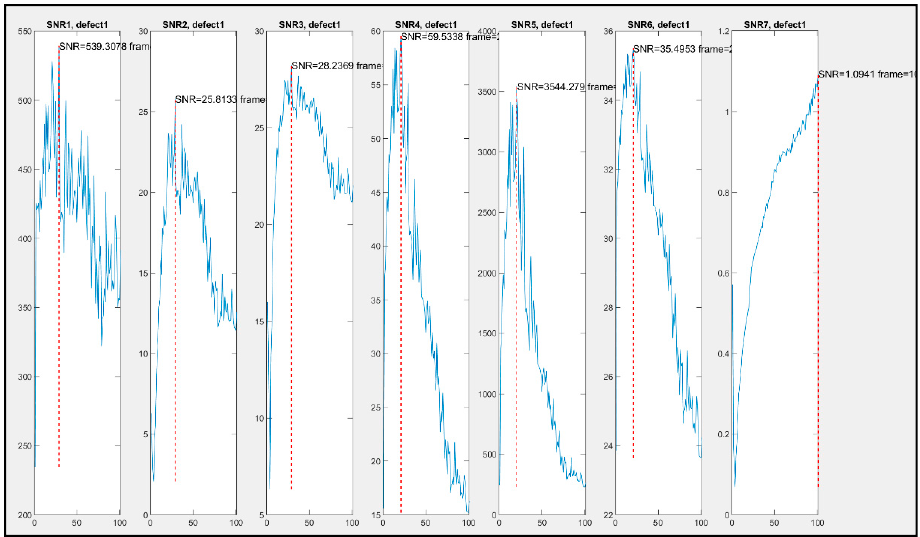
Figure 13. Seven signal-to-noise ratio (SNR) calculations from data 2.2. Cooled Front. All other SNR graphs are available but not included for simplification.